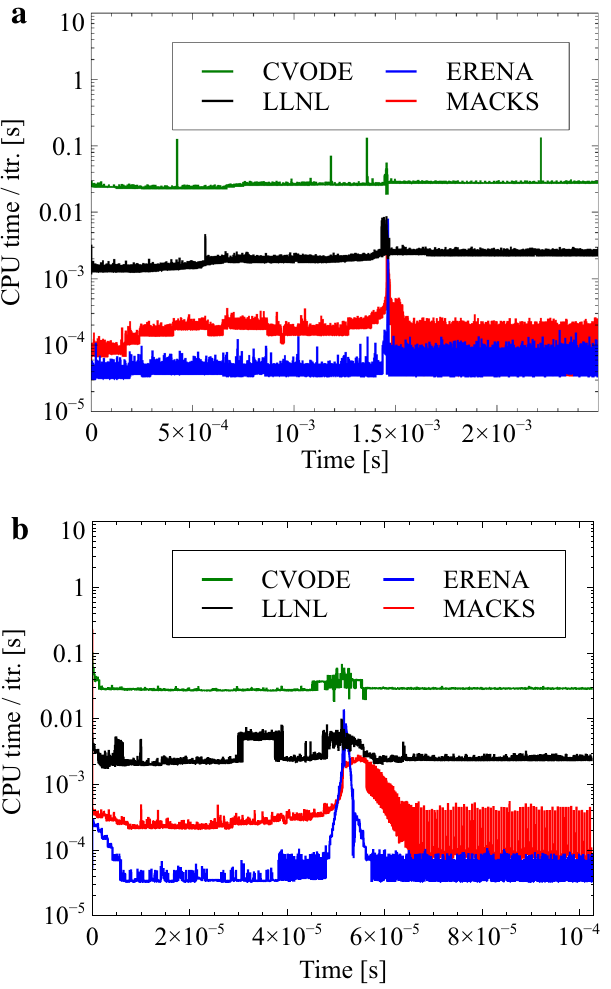
Figure 9. Time histories of computational cost per one-iteration with CVODE, LLNL, ERENA, and MACKS 8 s for a n - C 7 H 16 /air mixture with h = 1 × 10 − , p 0 = 2.0MPa , and T 0 = 800 and 1300